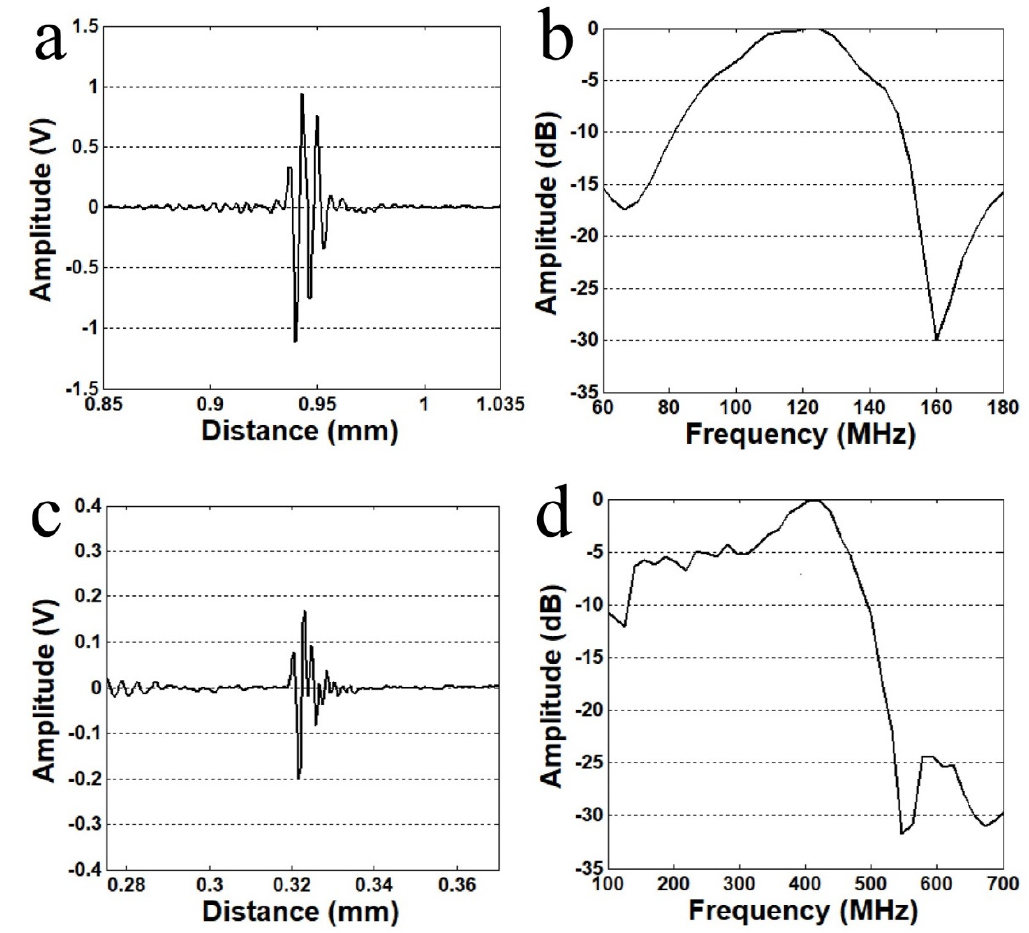
Figure 1. Pulse–echo measurements of fabricated transducers. ( a ) Echo response of 120 MHz transducer, ( b ) frequency spectrum of 120 MHz transducer, ( c ) echo response of 410 MHz transducer, and ( d ) frequency spectrum of 410 MHz transducer.